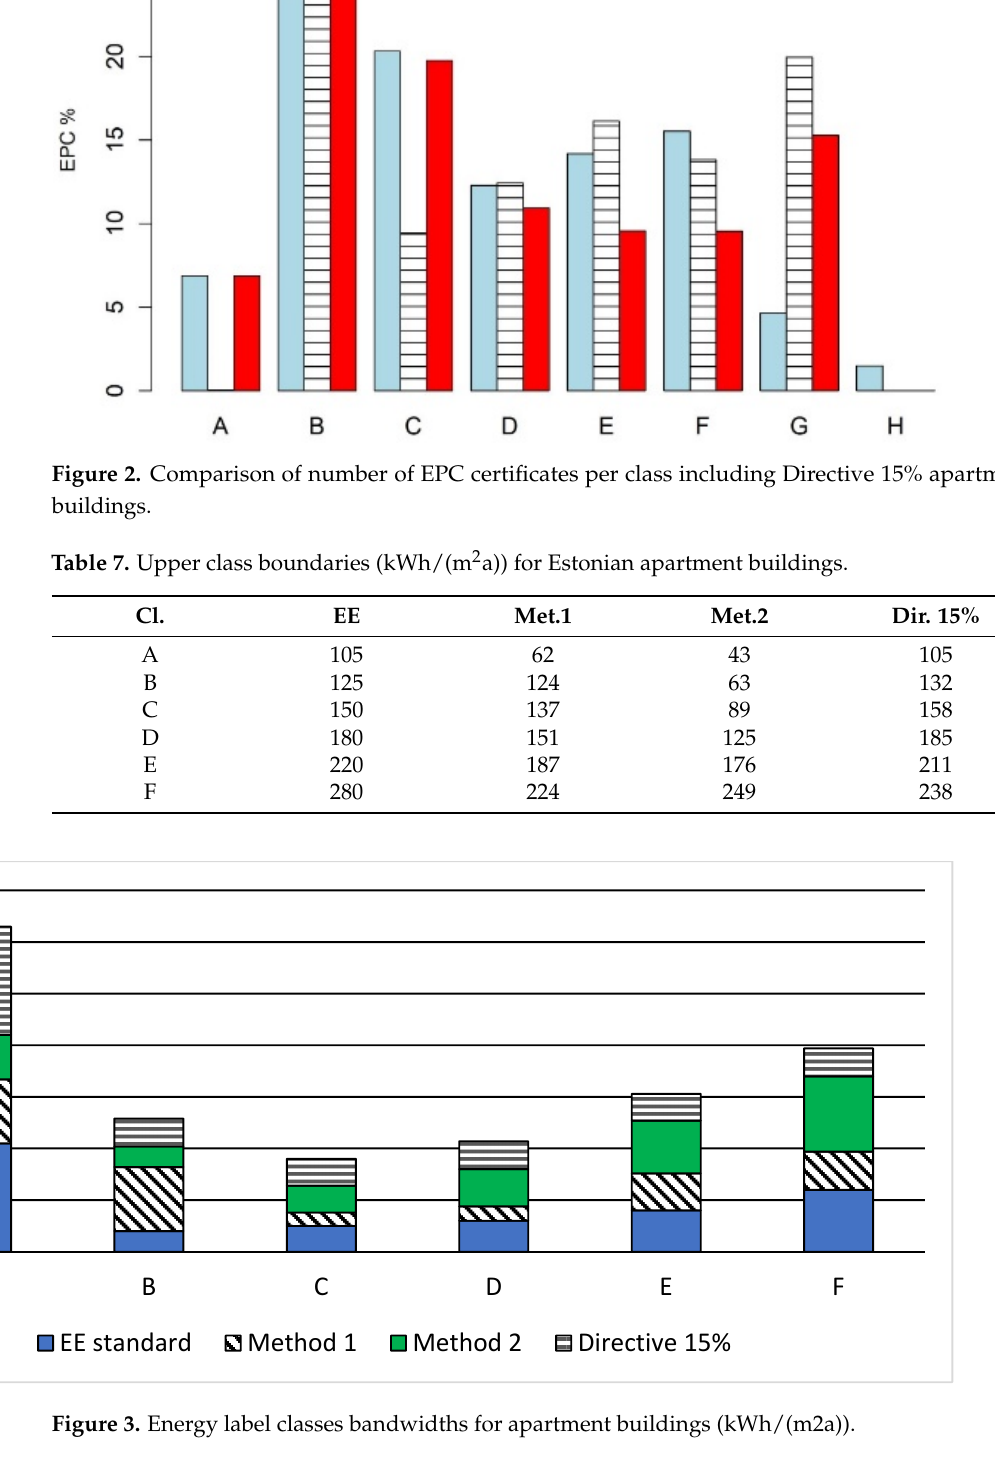
Table 8 . EPC certificates (%) per energy class, as allocated by the different methods, for apartment buildings.